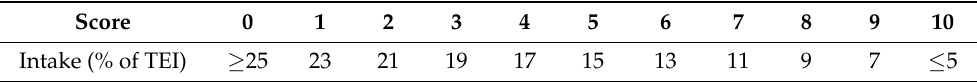
Table 4. Summary of score correspond to Added Sugar intake (% of